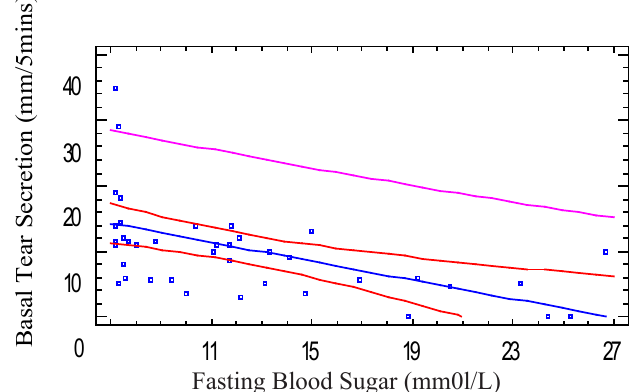
Figure 3: Relationship between fasting blood sugar and Tear Break Up Time (TBUT) in NIDDM group.